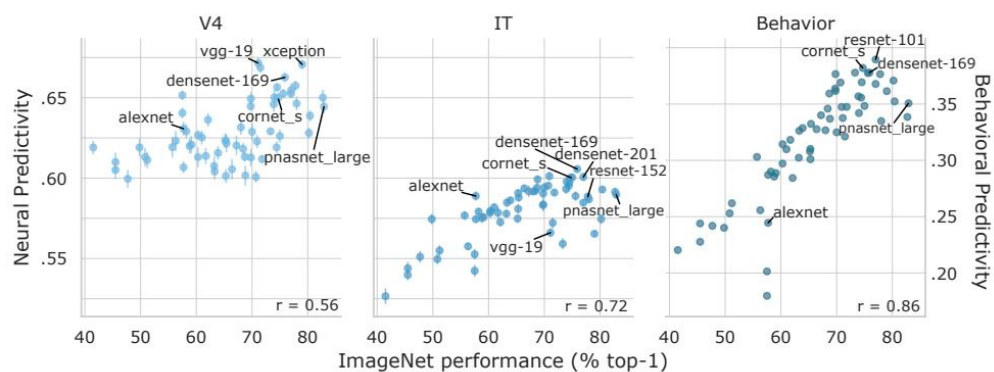
Figure 2. The performance of popular Deep Learning models based on their ability to match human V4 and inferior temporal (IT) regions, as well as human behavior performance. Adapted from “Brain-Score: which artificial neural network for object recognition is most brain-like?” by Schrimpf et al., 2018 [167], BioRxiv , 407007. Copyright 2018 by author. Reprinted with permission.